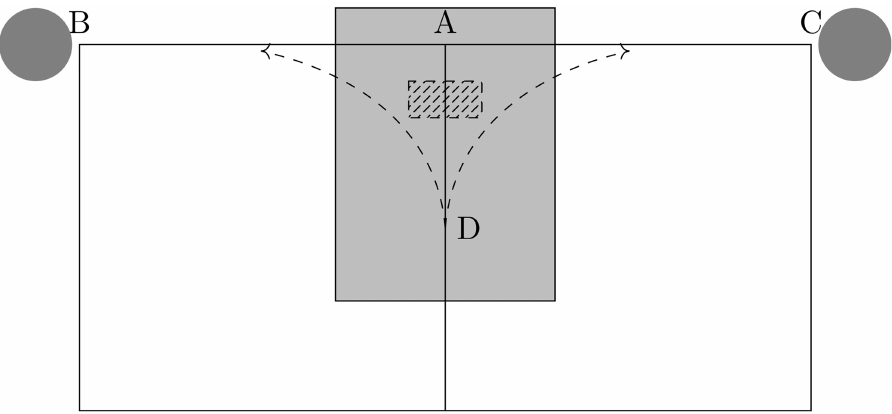
Fig 1. Schematic of the cued-choice task in a T-maze. A rat starts at D and then travels towards the decisionpoint, A. When it enters the regionmarked by the hatched rectangle, a sound cue is played. Depending on the frequency of the cue, the goal is located at either B or C, indicatedwith grey circles. The rat then returns to D, when the next trial starts. The decisionmodelledin our neuralcircuit occurs in the shaded